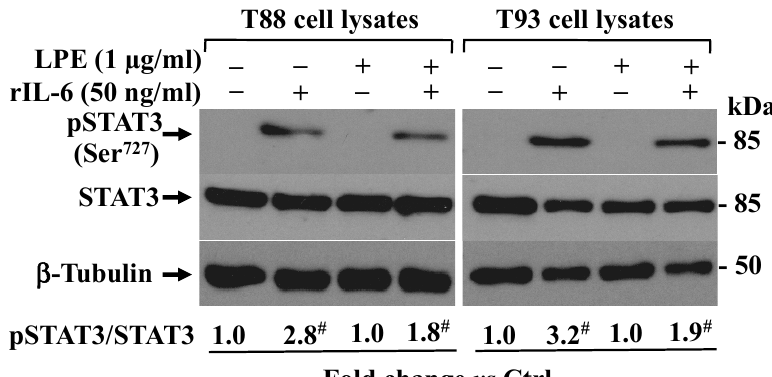
Figure 4. Effect of rIL-6 exposure with or without LPE pretreatment on STAT3 phosphorylation levels in T88 and T93 cells. Western blotting analysis of phospho-STAT3 protein expression levels in cells treated with rIL-6 alone (50 ng/mL for 24 h) or after preincubation with LPE (1 µ g/mL GAE for 6 h) and then exposed to rIL-6 (50 ng/mL for 24 h). The relative phospho-STAT3/STAT3 protein fold change level in the treated cells was calculated vs. the untreated cells, set to 1, is shown under each lane. Results are presented as mean ± SD ( n = 3) (# p < 0.001, statistically significant vs. untreated cells).